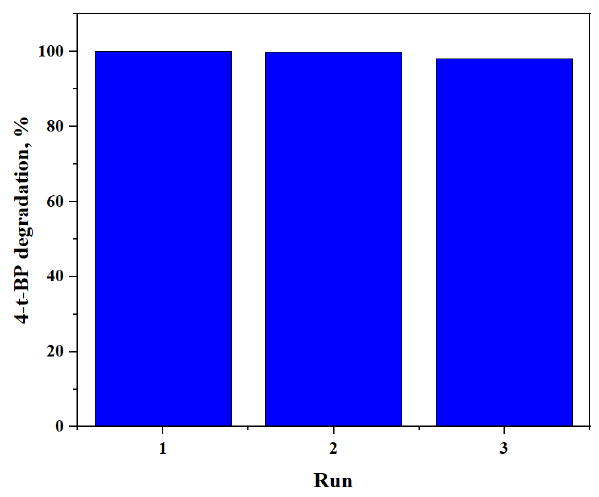
Figure 10. Cyclic experiments of Ag 2 CO 3 toward the degradation of 4-t-BP. Experimental conditions: [4-t-BP] 0 = 5 ppm, catalyst dosage = 200 mg/L.